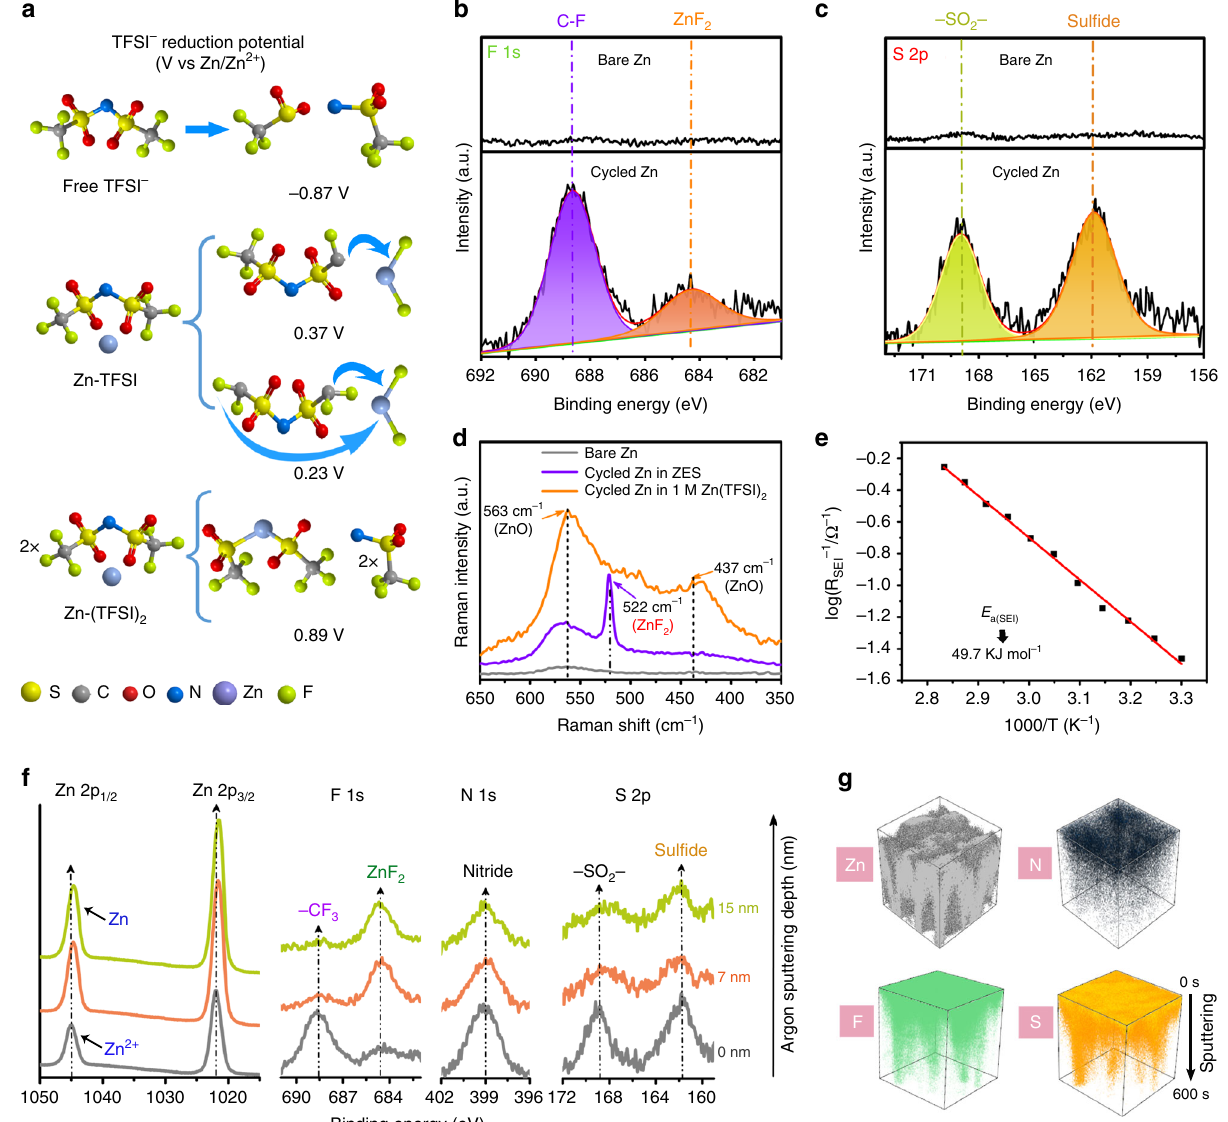
Fig. 4 Experimental and theoretical investigations on the existence and the composition of the Zn-compatible SEI layer. a Predicted reduction potentials by DFT calculations. XPS spectral regions for b F 1s and c S 2p of the surface of bare Zn (top) and after cycled Zn (bottom), respectively. d Raman spectra of the cycled Zn anode in ZES and 1 M Zn(TFSI) 2 . e Arrhenius behavior of the reciprocal resistances corresponding to interfacial components and the activation energy derived for the in situ formed SEI. f XPS spectral regions for Zn 2p, F 1s, N 1s, and S 2p at various argon (Ar + ) sputtering depths on the SEI accumulated on Zn substrate. g Three-dimensional view of Zn, N, F, and S elements distributions of SEI in the time-of- fl ight secondary-ion mass spectrometry (TOF-SIMS) sputtered volumes. The SEI-coated Zn anode was obtained after 20 cycles of galvanostatic plating/stripping in ZES electrolyte (Zn/Zn cells at 0.5 mA cm − 2 with a capacity of 1 mAh cm − 2 for each half